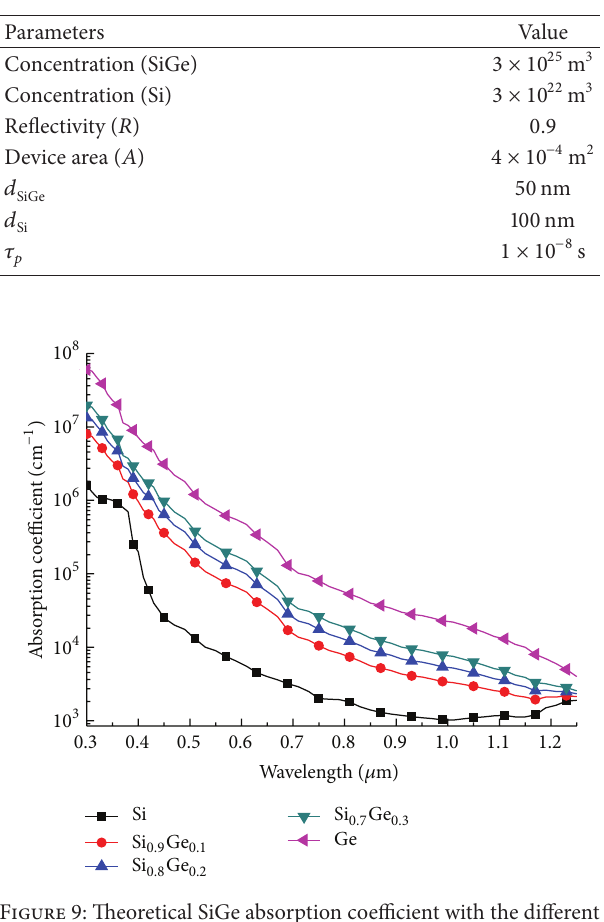
Figure 9: Theoretical SiGe absorption coefficient with the different Ge content.